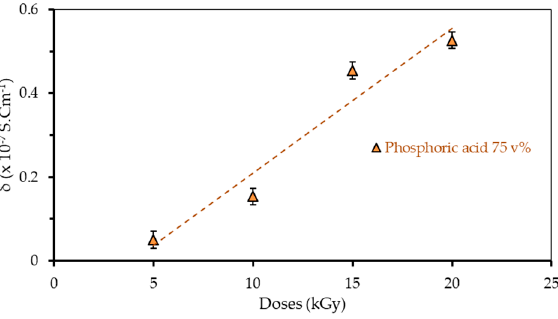
Figure 9. Electrical conductivity of the polymer film blended with H 3 PO 4 75 v%.